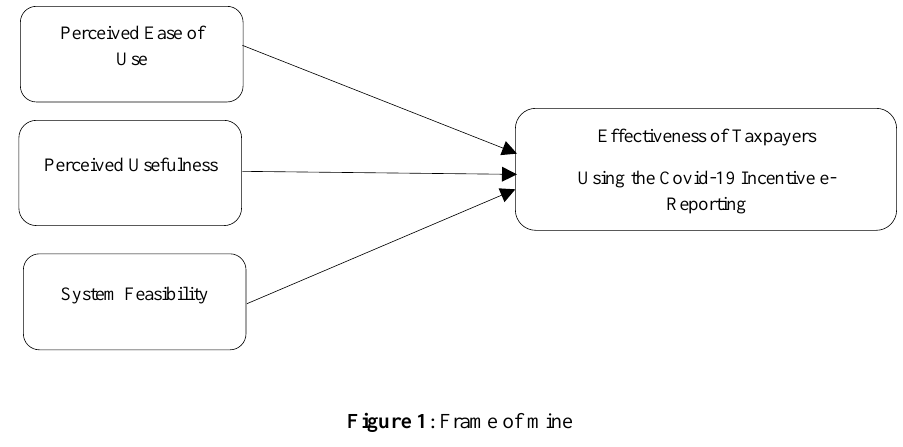
Figure 1 : Frame of